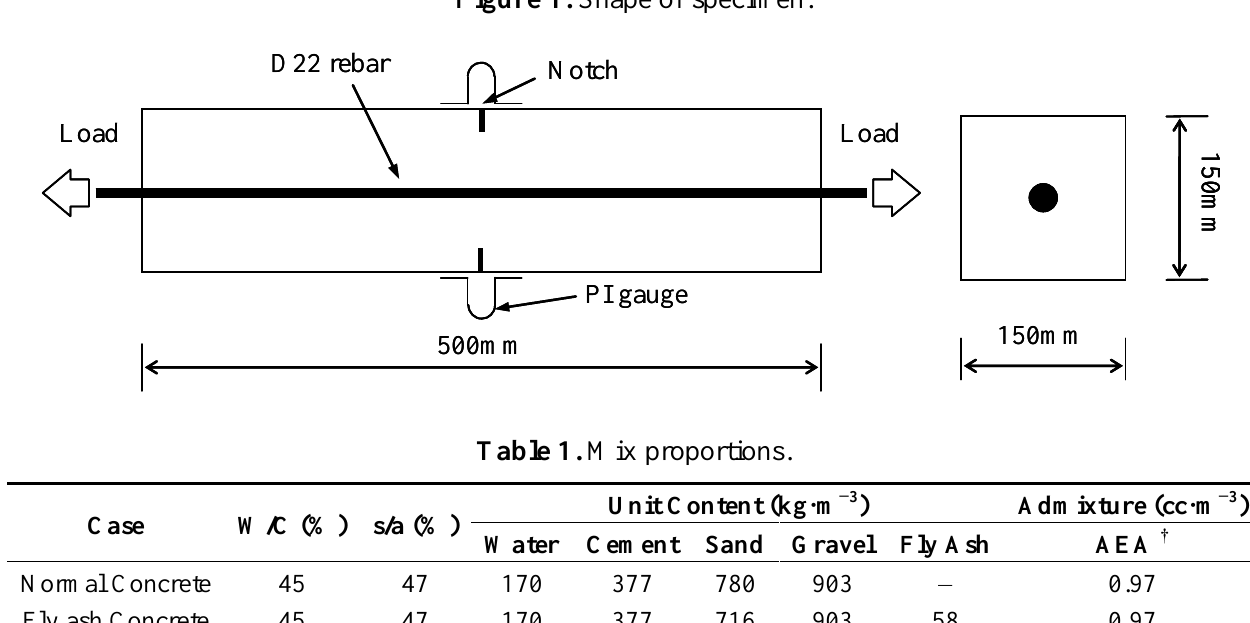
Figure 1. Shape of specimen.